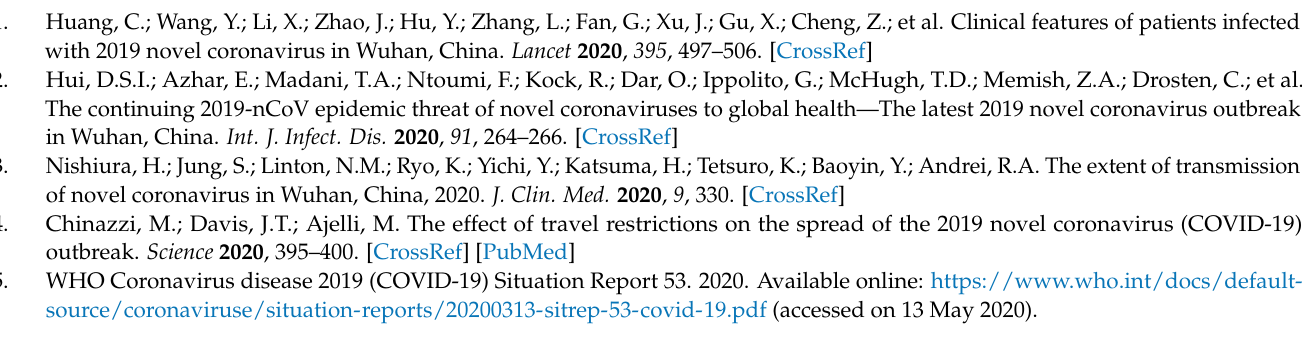
Hokkaido, Figure S2: Epidemic curves by date of confirmation ( A ) and date of illness onset ( B ) as